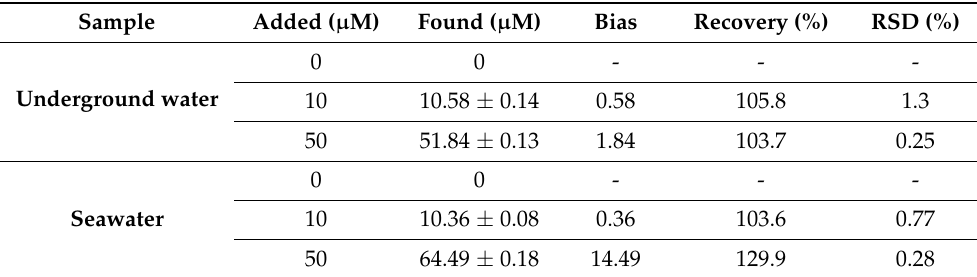
Table 1. Results for determining Cd (II) in real water samples.